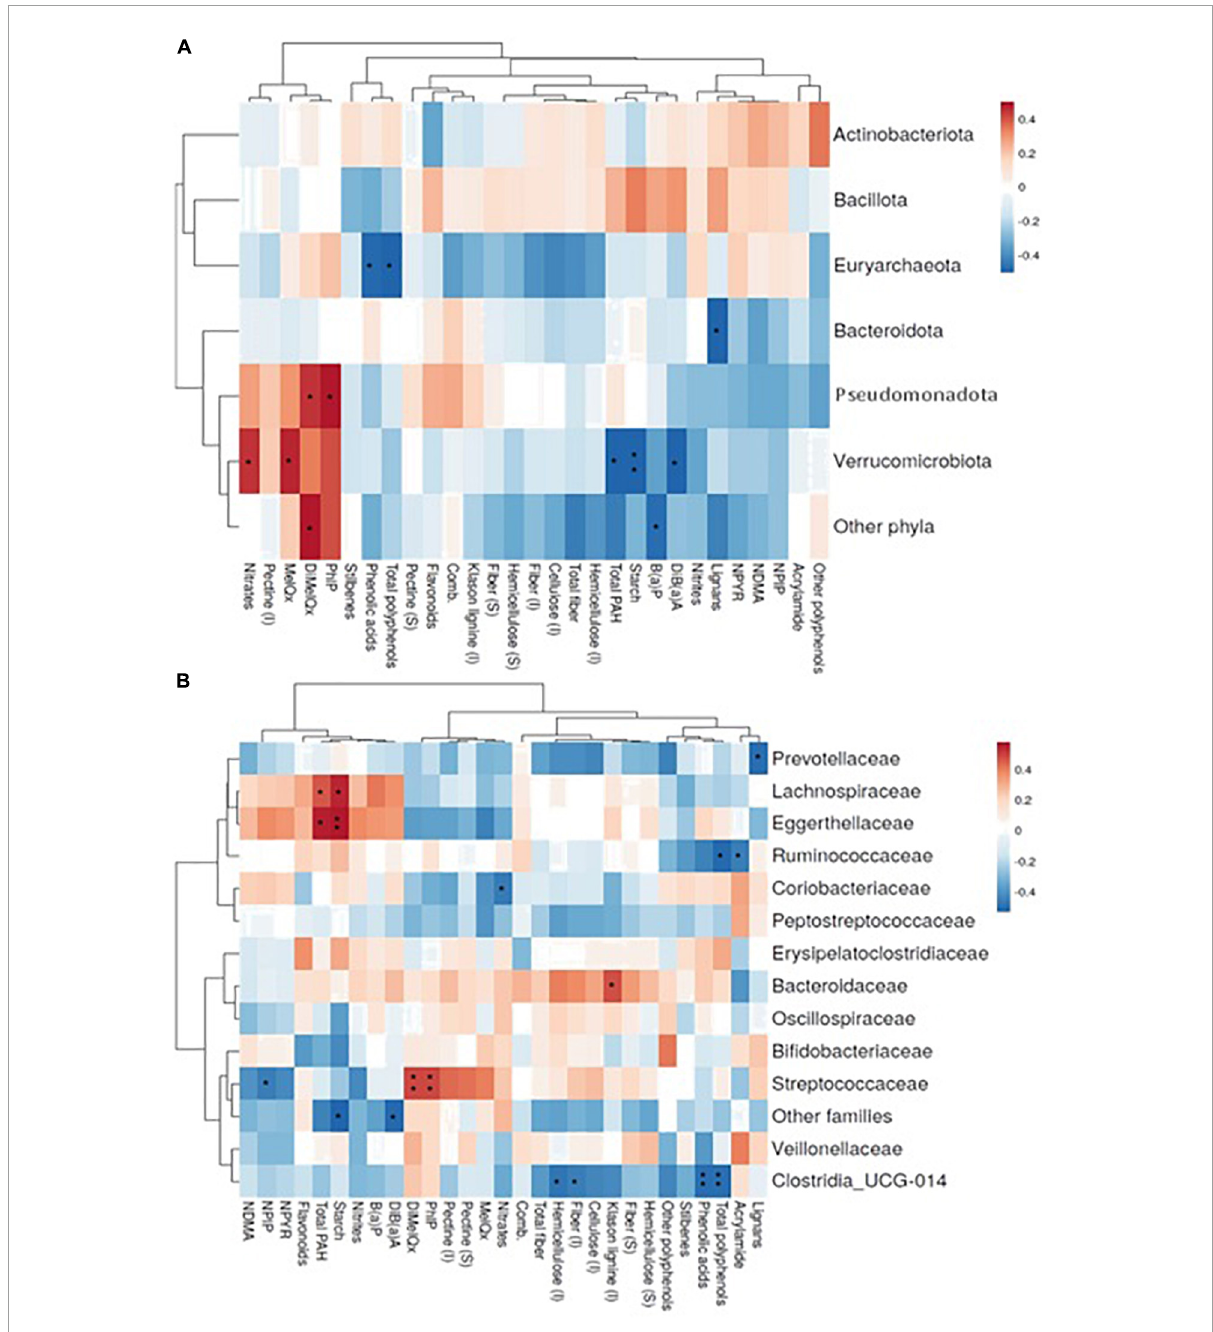
FIGURE2 Spearman correlations representation between the most abundant bacterial phyla (A) or families (B) (rows) and consumption of xenobiotics and bioactive compounds derived from the diet in the sample (columns). ( ∗ ), ( ∗∗ ) p – value < 0.05 and 0.01, respectively. Only taxa showing mean relative abundances higher than 1% are shown. MeIQx, 2-amino-3,8 dimethylimidazo (4,5,f) quinoxaline; DiMeIQx, 2-amino-3,4,8 trimethylimidazo (4,5,f) quinoxaline; PhIP, 2-amino-1-methyl-6-phenylimidazo (4,5,b) pyridine; B(a)P, benzo (a) pyrene; DiB(a)A, dibenzo (a) anthracene; Total PAH, total polycyclic aromatic hydrocarbons; NDMA, N-nitrosodimethylamine; NPIP, N-Nitrosopiperidine; NPYR, N-Nitrosopyrrolidine; (I), insoluble; (S),